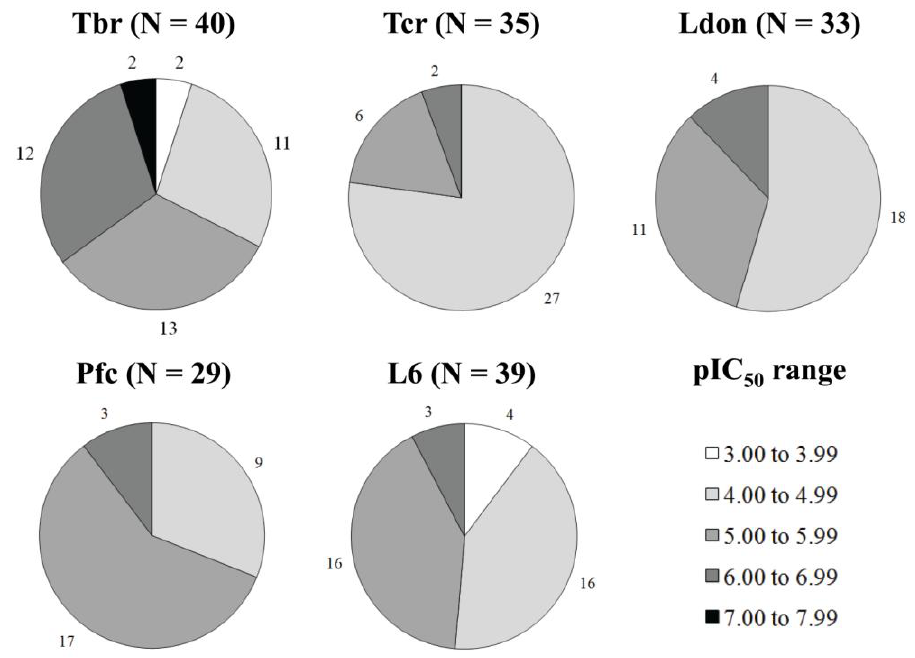
Figure 1. pIC distribution of the dataset of 40 STLs over the five biological activities 50 under study. Each graph represents the respective number of compounds with measured pIC (N) values in a particular concentration range against each tested parasite and 50 cytotoxicity